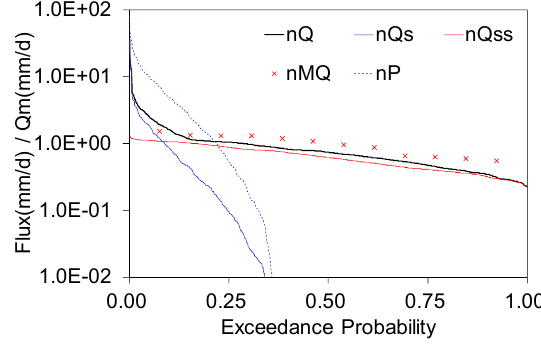
Fig. 2. An example of the decomposition of the flow duration curve normalized by mean annual daily flow Q m . “ nQ ”, “ nQ s ”, “ nQ ss ”, “ nP ” are normalized duration curves of daily flow, daily surface flow, daily subsurface flow, and daily precipitation; “ nMQ ” is flow duration curve associated with the regime curve - ensemble aver- aged mean within-year daily flow variation normalized by mean an- nual daily flow Q m ). We calculated exceedance probabilities for nQ , nQ s , nQ ss , and nP as the order numbers sorted by their mag- nitudes for a total of 3 years divided by 1096 which is 365 × 3+1. For the exceedance probability of nMQ , we calculated the sorted or- der of the mean monthly flow divided by 13 which is 12+1. Hence, precipitation and surface flow occurred about 1/3 of the total calcu- lation period and subsurface flow appeared every time period. Dry- ness index is 0.5, and seasonal peaks of precipitation and potential evapotranspiration are in phase making a humid summer